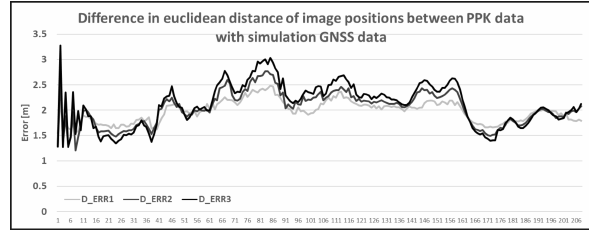
Figure 9. The difference in euclidean distance of image positions between post processed and simulated GNSS data.